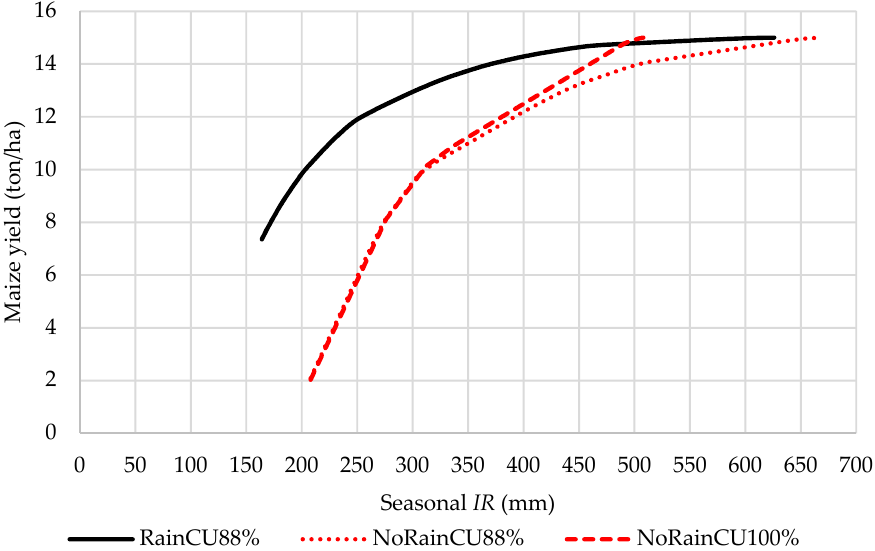
Figure 7. Maize yield as a function of applied irrigation water ( IR ) for a uniform (CU100%) and a non-uniform (CU88%) application in the presence rainfall (Rain) and no rainfall (NoRain).